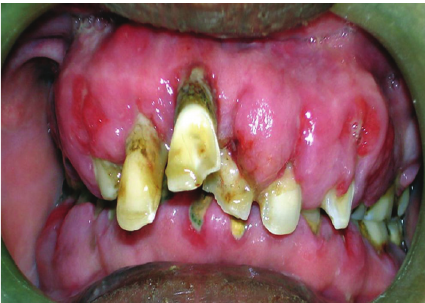
Figure 1: Showing generalized amlodipine-induced gingival enla- rgement.